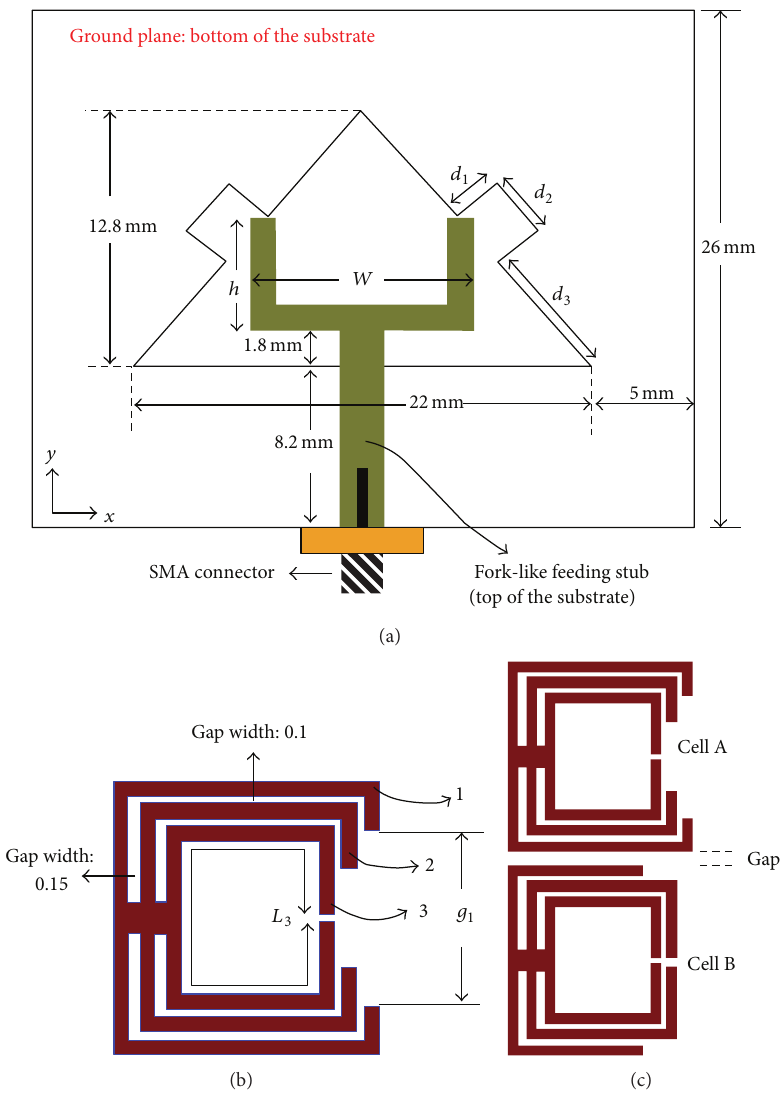
Figure 1: Geometry and design parameters of the proposed: (a) microstrip slot antenna, (b) unit cell of the FSS screen, and (c) combination of two